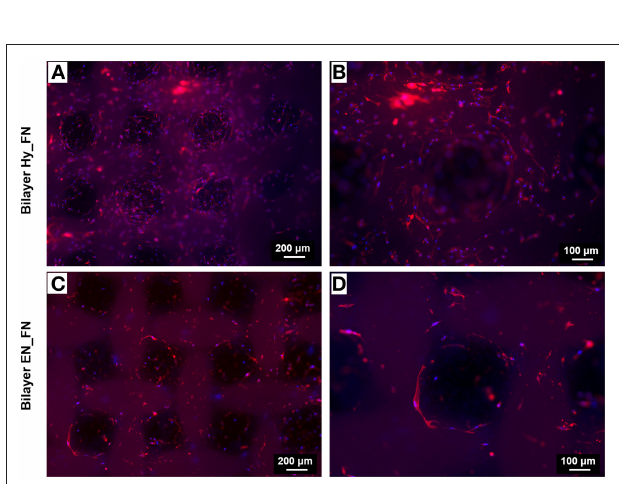
FIGURE 12 | Fluorescence images of actin filaments (red) and cell nuclei (blue) for the bilayered samples Bilayer Hy_FN (A,B) and Bilayer EN_FN (C,D) with two